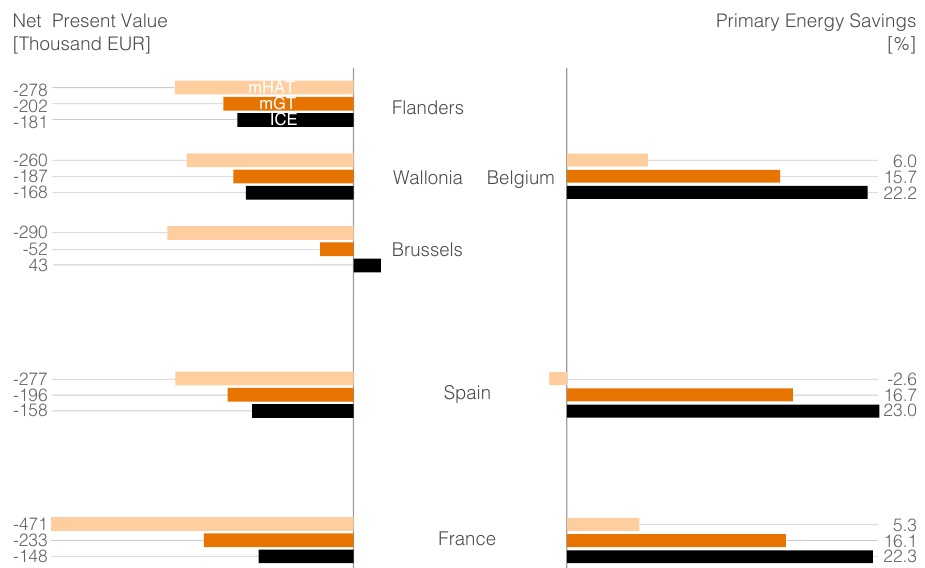
Figure 12. None of the technologies is feasible in any of the countries, despite the fact that (except mHAT in Spain) they all provide